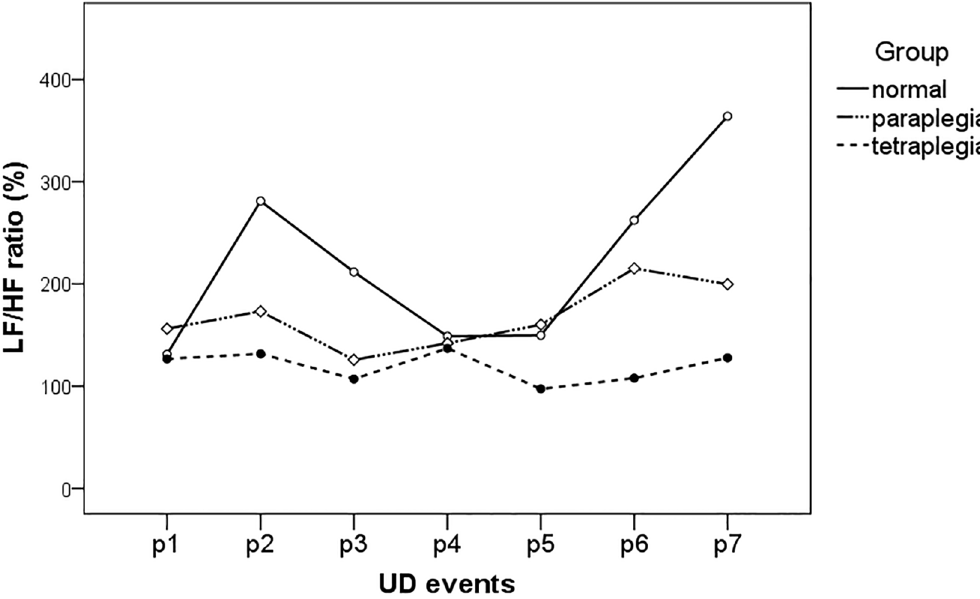
Fig 2. The changes of HRV parameters, LF/HF ratio during UDS of the three groups. These seven time points were: after lying quietly for 15 min (p1), Foley catheter insertion (p2), start of infusion (p3), and infused volume at 1/ 4 (p4), 2/4 (p5), 3/4 (p6) and 4/4 (p7) of maximum